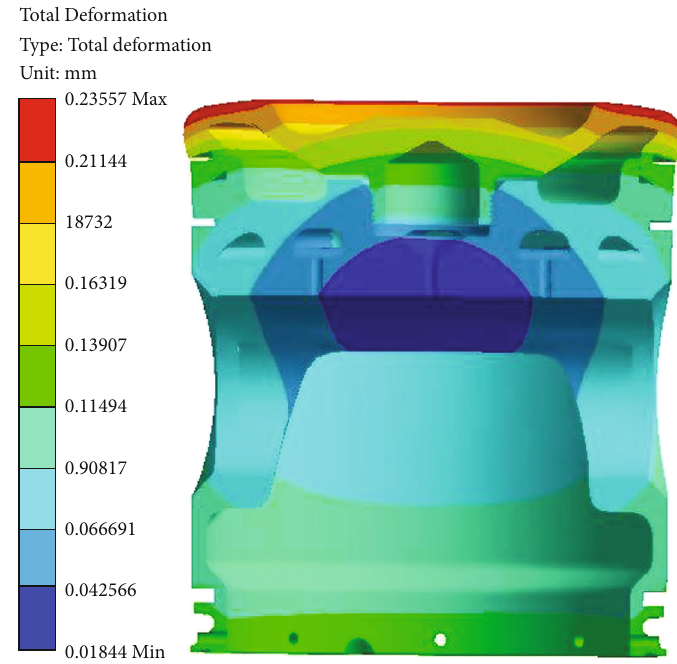
Figure 16: The deformation nephogram of the piston under new scheme